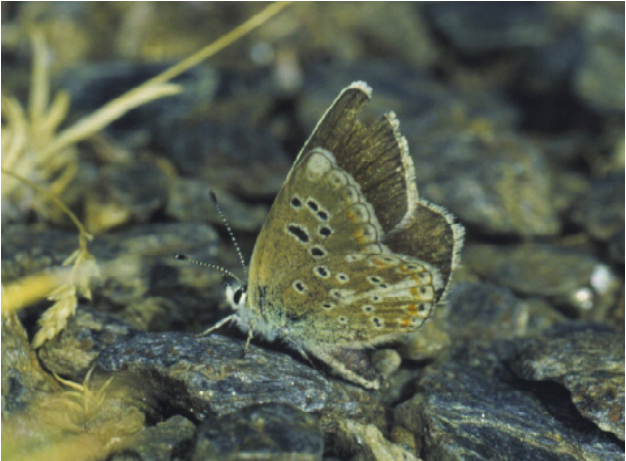
E: Corsican Fritillary F: Le Nacré